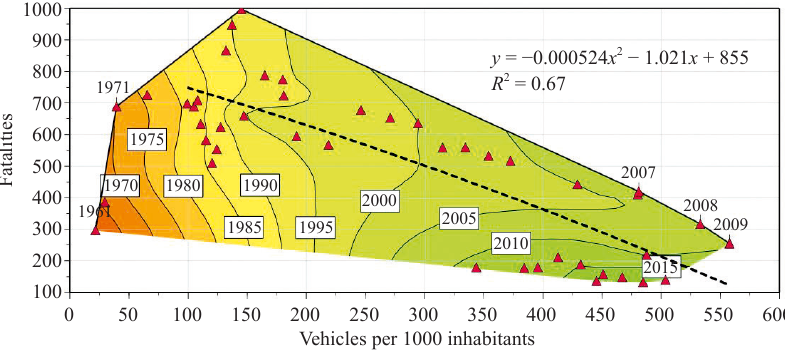
Figure 8. Car ownership and fatality development